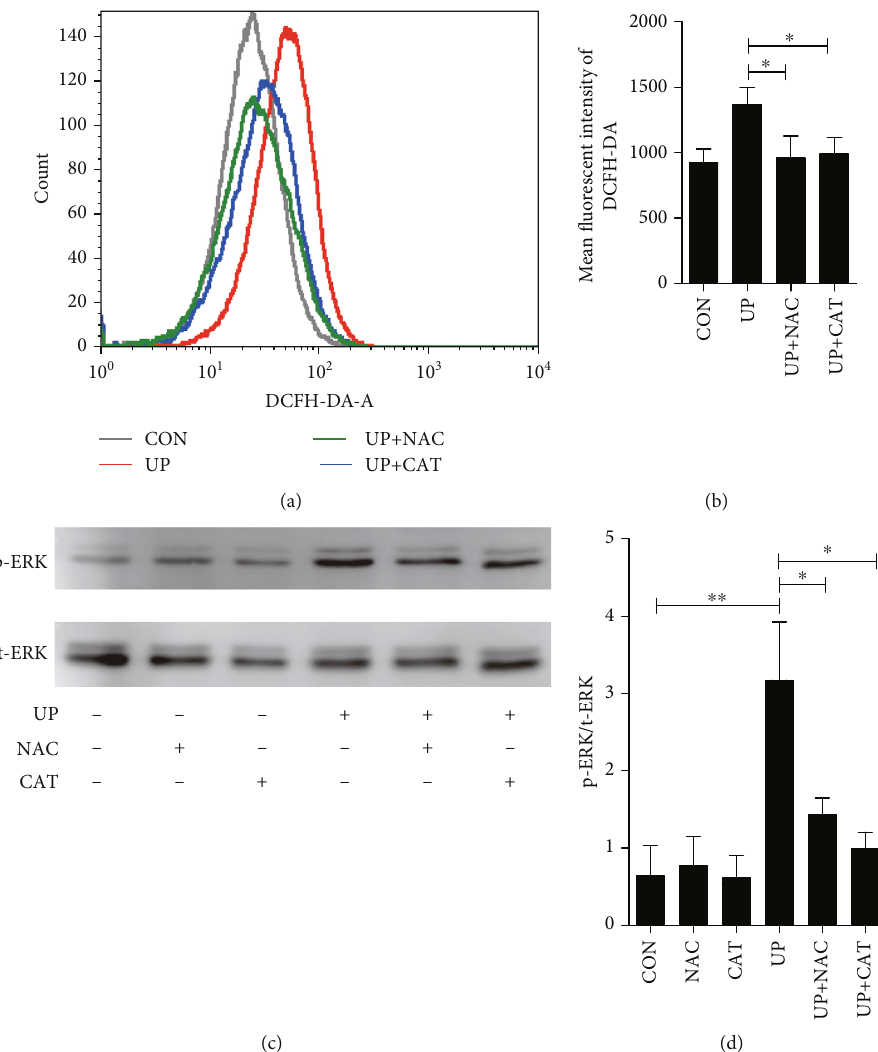
Figure 1: E ff ect of antioxidants on urinary protein-induced ERK pathway activation. Antioxidants NAC (10 mM) and CAT (2000U/ml) were administered 1h before the addition of 8 mg/ml urinary proteins for 2h. Cell culture supernatant was subjected to DCFH-DA fl ow cytometry analysis of ROS levels (a, b). After treatment with urinary proteins for 4 h, aliquots of cell lysate were subjected to Western blot analysis of p-ERK and t-ERK level (c, d). (b) F ð 38 Þ = 4 : 901 ; (d) F ð 5 12 Þ = 5 : 581 . ∗ P < 0 : 05 and ∗∗ P < 0 : 01 . CON: control; NAC: N- acetylcysteine; CAT: catalase; UP: urinary